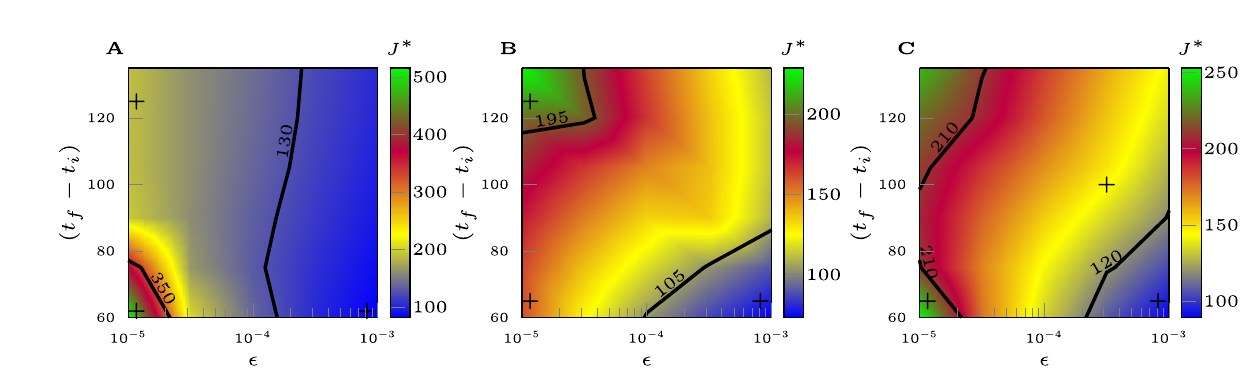
Figure 4. Effects of varying the terminal suppression constraint ǫ and the control horizon t f − t i . ( A ) The optimal cost J ∗ obtained as the solution of the optimization problem (4) vs. the parameter ǫ . ( B ) The optimal ∗ cost J alt obtained as the solution of the optimization problem (7) vs. the parameter ǫ . ( C ) The optimal cost J ∗ obtained as the solution of the optimization problem vs. the control horizon ( t f − t i ) . ( D ) The optimal cost J alt obtained as the solution of the optimization problem (7) vs. the control horizon ( t f − t i ) . The parameter c q and c p are both set to 1.